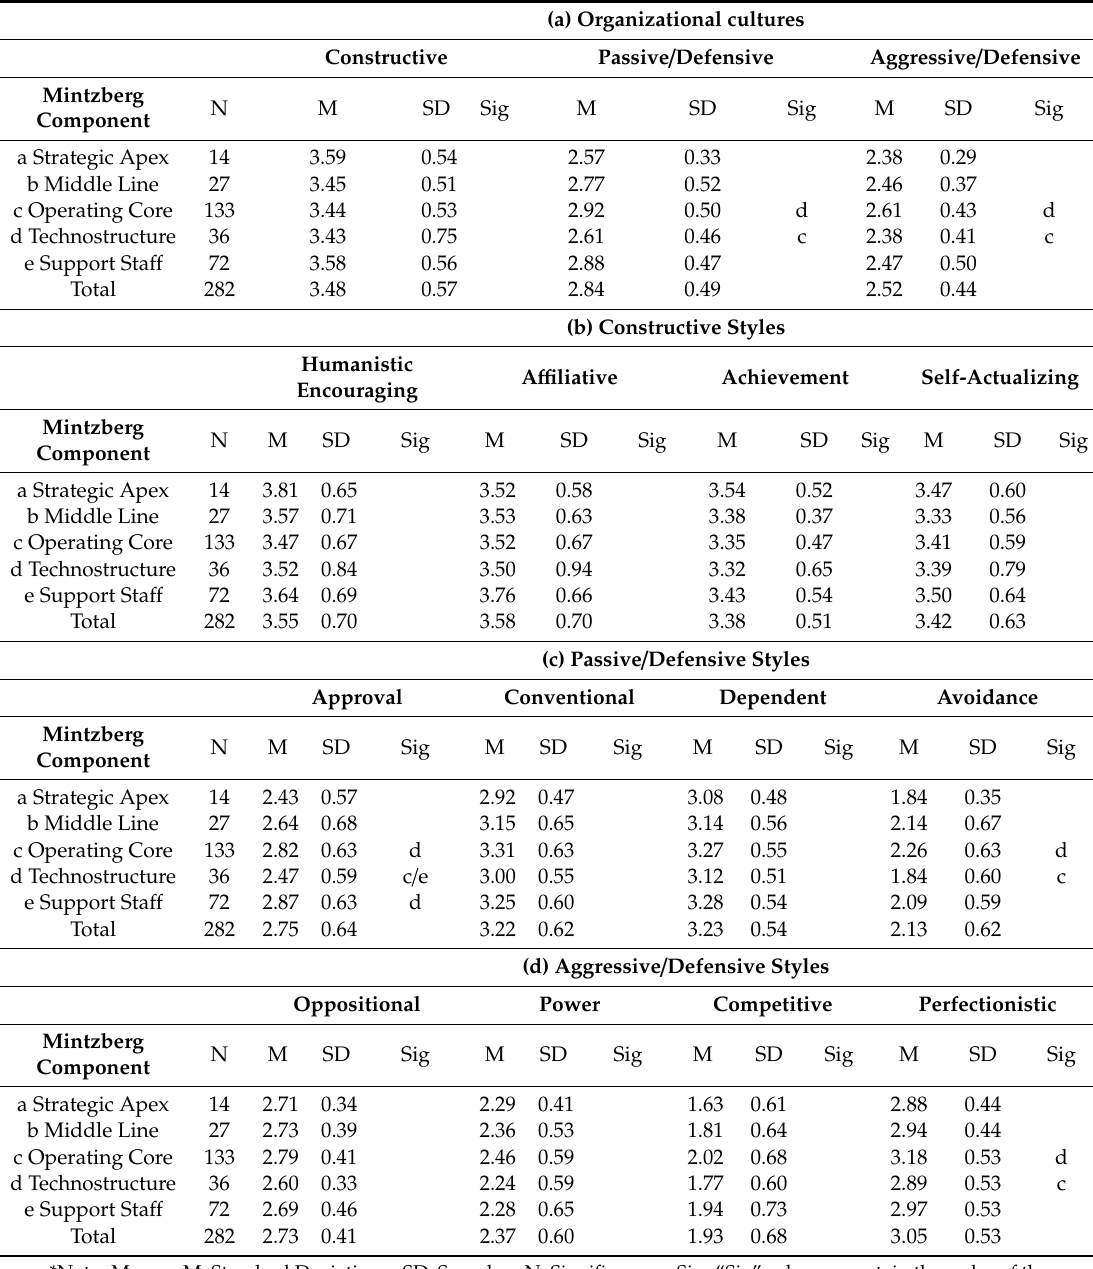
Table 10. Descriptive statistics by Mintzberg’s components of the (a) OCI organizational cultures; (b) OCI “Constructive” styles; (c) OCI “Passive / Defensive” styles and (d) OCI “Aggressive / Defensive” styles